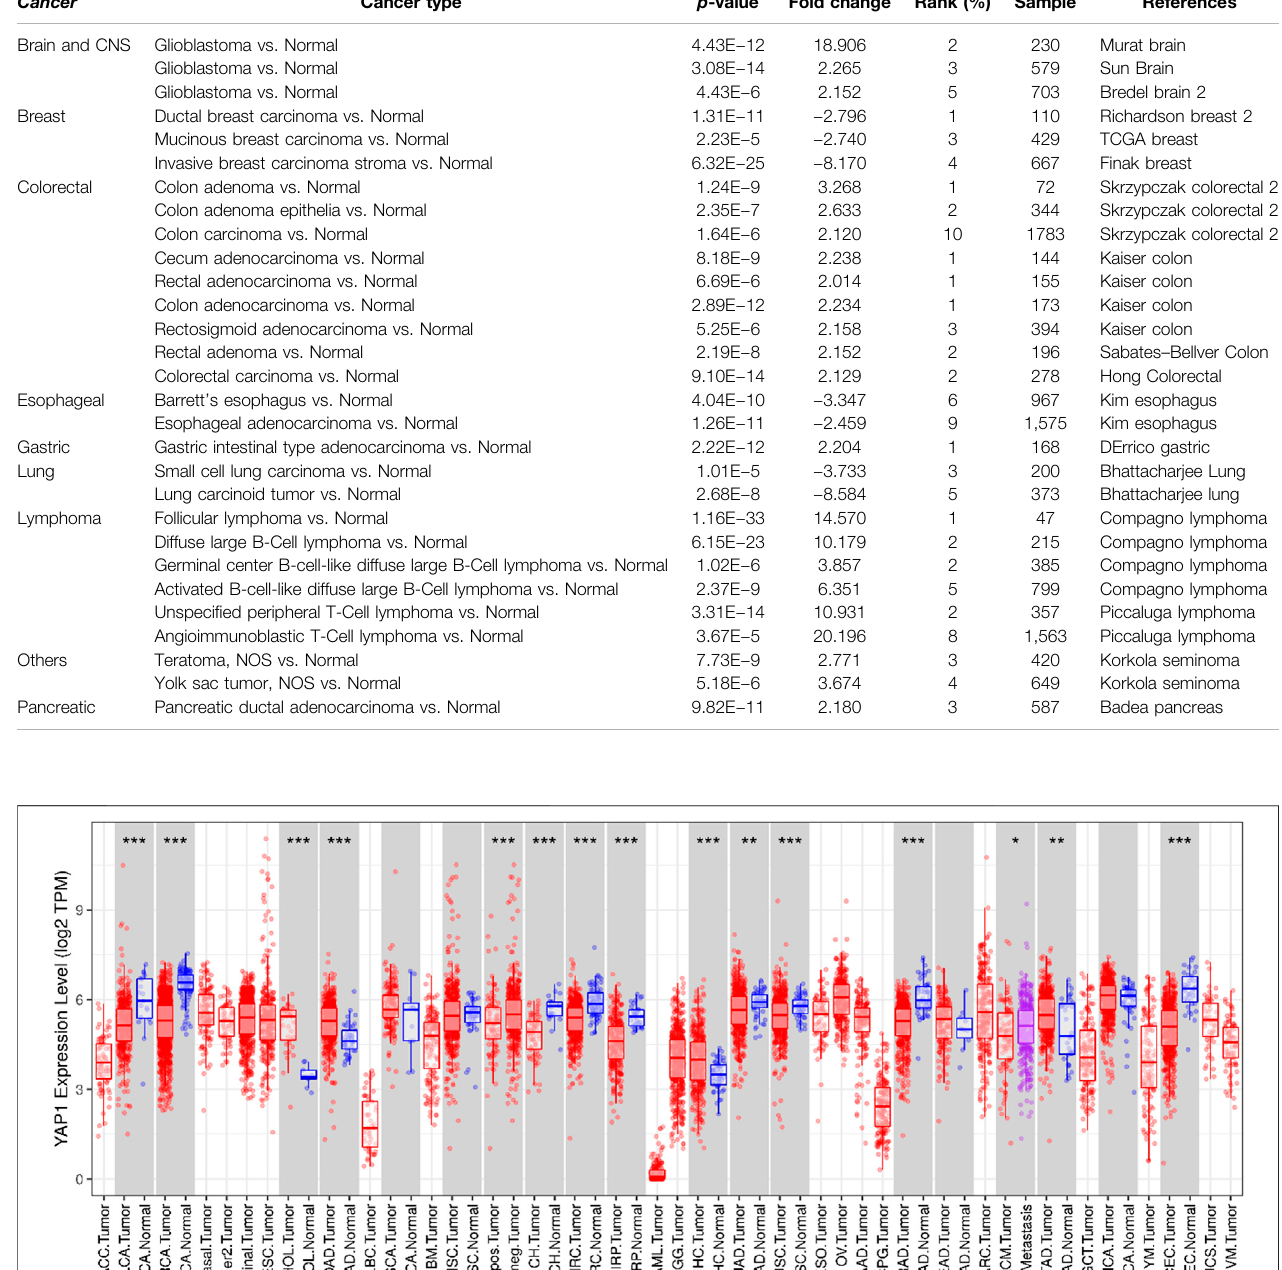
adenocarcinoma (PAAD), STAD, and Thymoma (THYM). In contrast, the expression of YAP1 was signi fi cantly lower in tumor tissues than in normal control tissues in Adrenocortical carcinoma (ACC), BLCA, Pheochromocytoma and Paraganglioma (PCPG),